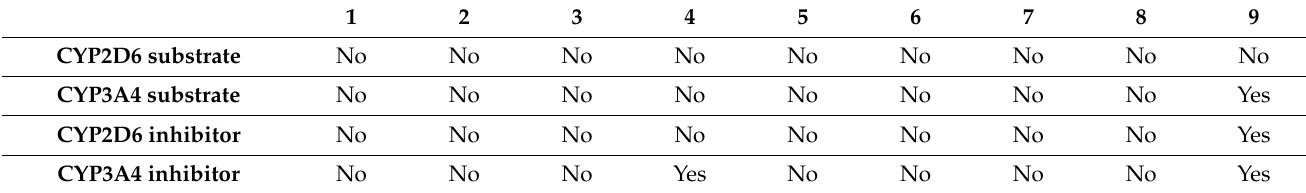
Table 5. Metabolism parameter prediction of A. halimus leaf ethanolic extract. ( 1 ) Gallic acid, ( 2 ) syringic acid, ( 3 ) trans-ferulic acid, ( 4 ) myricetin, ( 5 ) catechin gallate, ( 6 ) caffeic acid, ( 7 ) chlorogenic acid, ( 8 ) arbutin, ( 9 ) trimethoxyflavone.